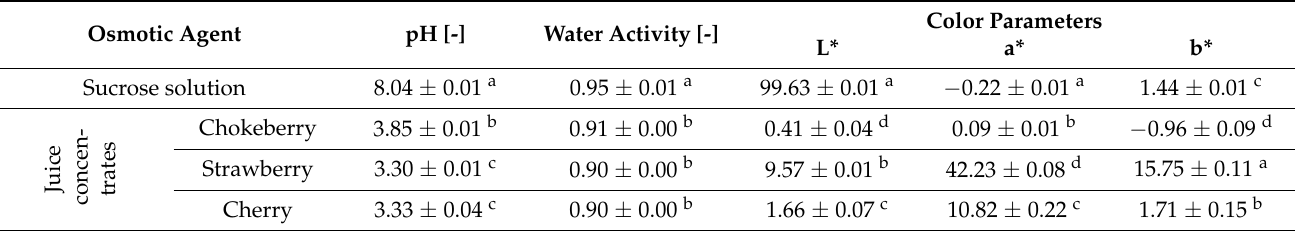
Table 1. Characteristics of osmotic